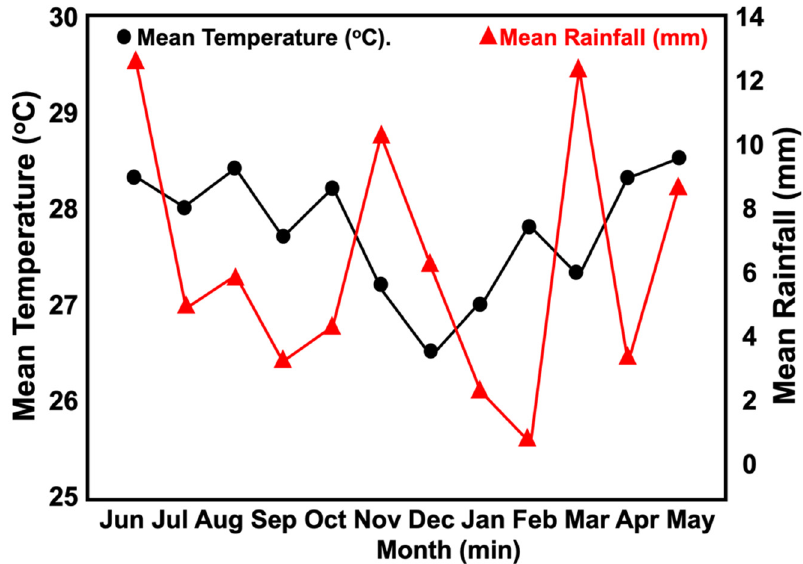
Figure 1. Mean temperature and rainfall between June 2020 to May 2021 in the field area.